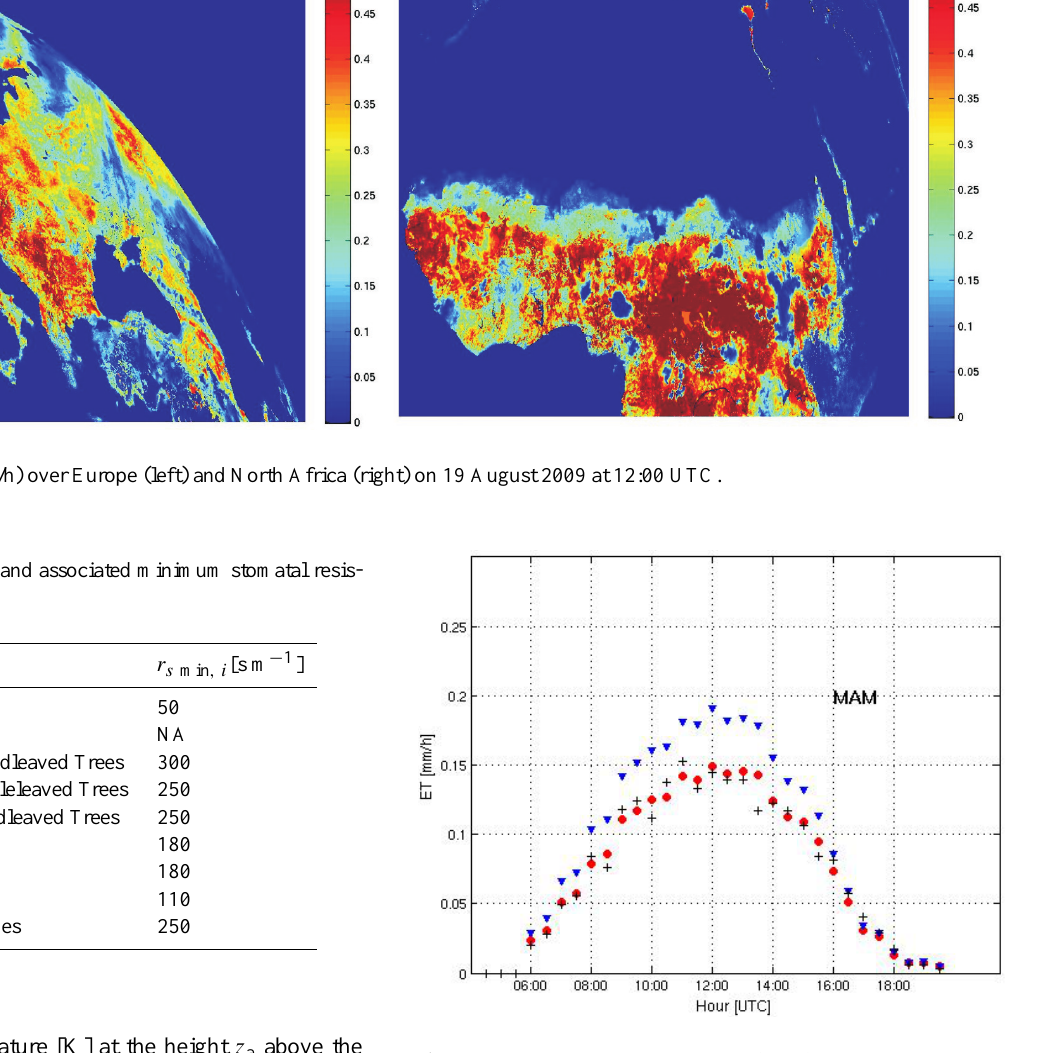
Fig. 2. Mean seasonal diurnal cycle of ET for the CarboEurope-IP Vielsalm station for March to May (MAM) 2007. Observation (+), pixel (v) and “tile” (o) estimate from LSA-SAF